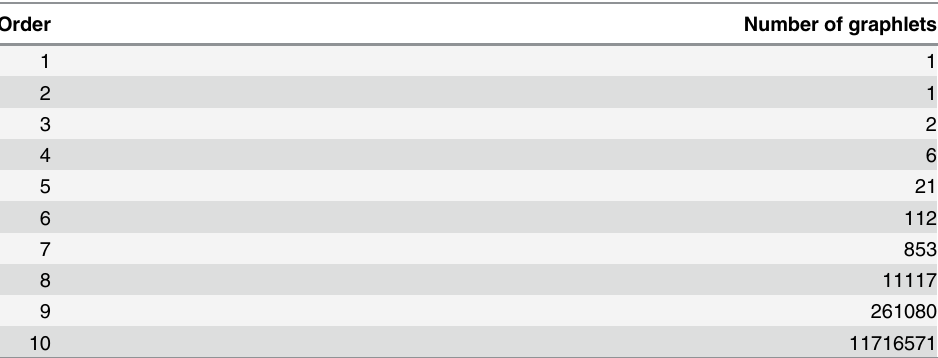
Table 1. The number of graphlets with n